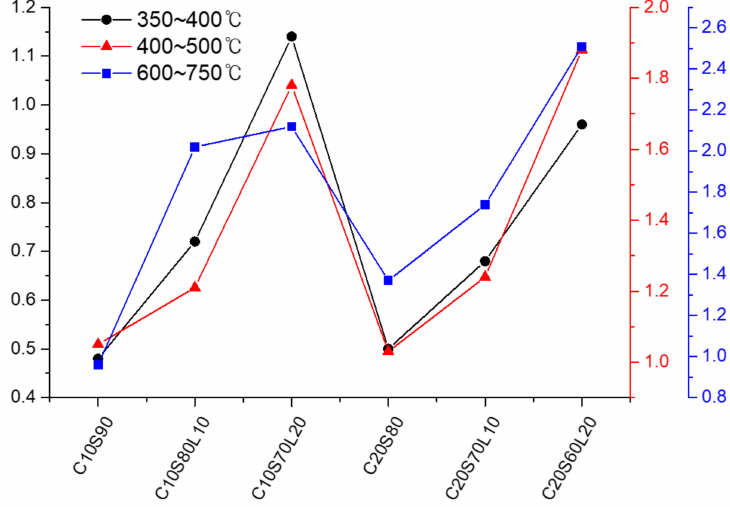
Figure 12. Mass loss fractions at di ff erent temperature ranges of AAS mixtures as a function of